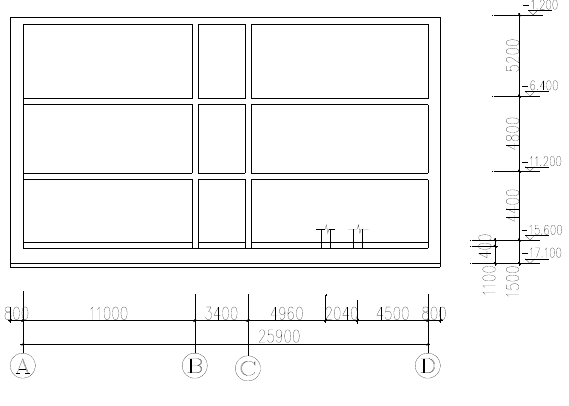
Figure 4. Short cross-section.